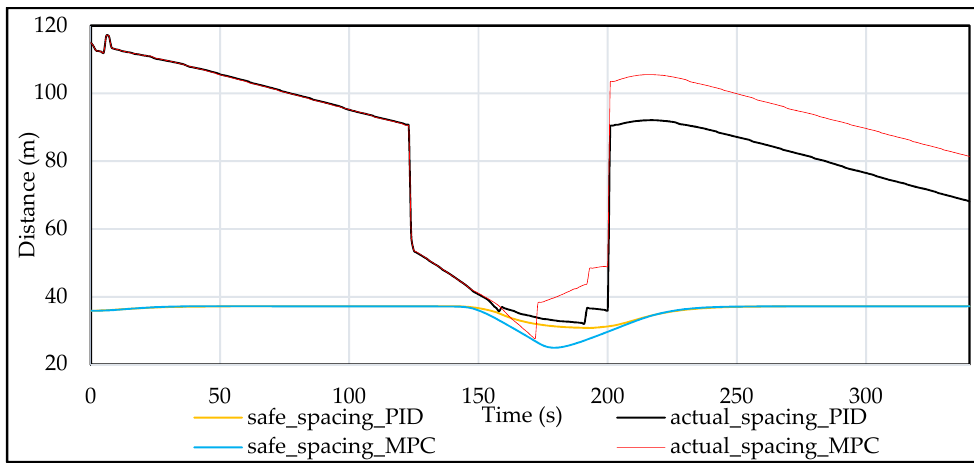
Figure 13. Acceleration response in scenario 2. Appl. Sci. 2020 , 10 , x FOR PEER REVIEW